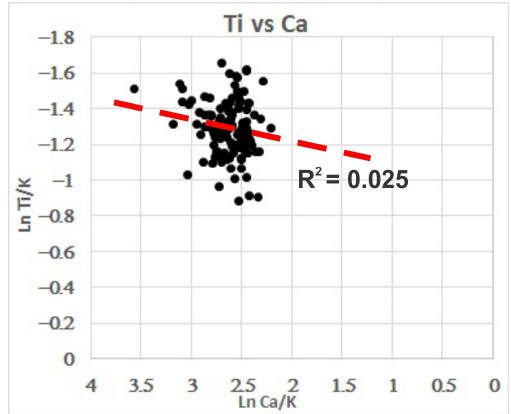
Figure 3. Linear correlation of Ti vs Ca (red dashed line). Each element normalized by K. The low correlation coefficient confirm that the source of Ca (marine) is different from Ti (land).